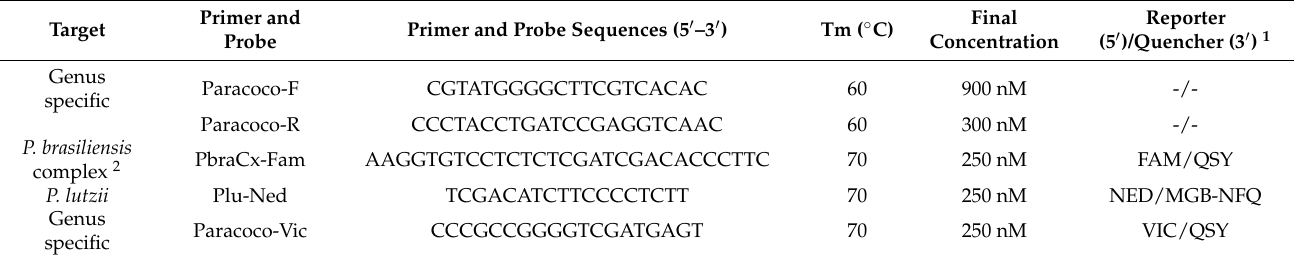
Table 1. Primer and TaqMan probe sequences used in the Paracoccidioides multiplex qPCR